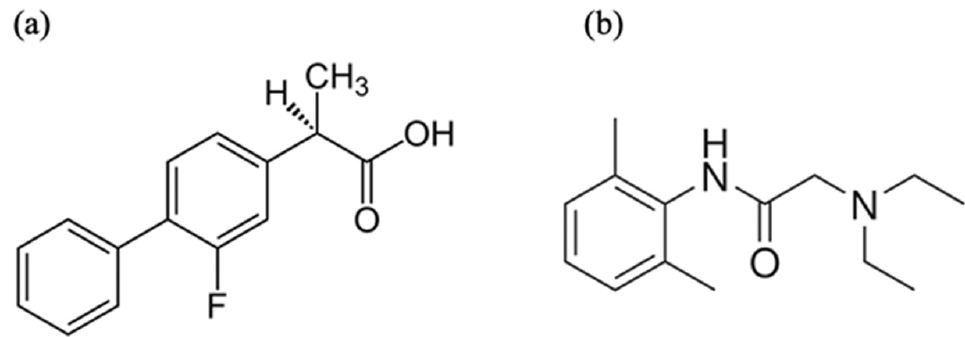
Figure 1. Chemical structures of the investigated molecules ( a ) Flurbiprofen (FLU) and ( b ) lidocaine (LDC).